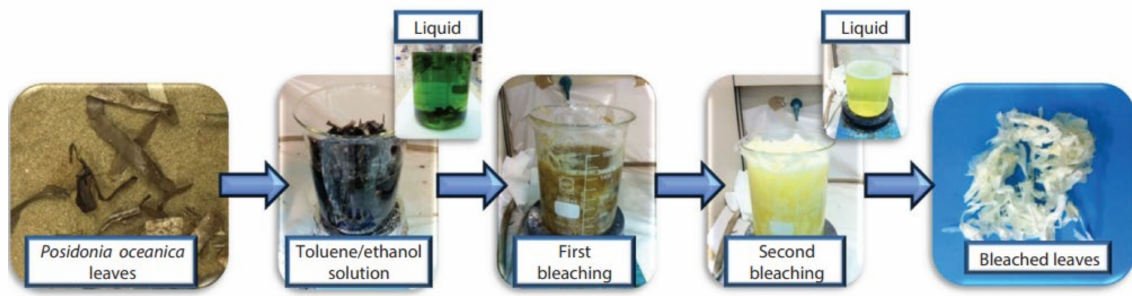
Figure 8. Pretreatment of Posidonia oceanica leaves [82]. (Open